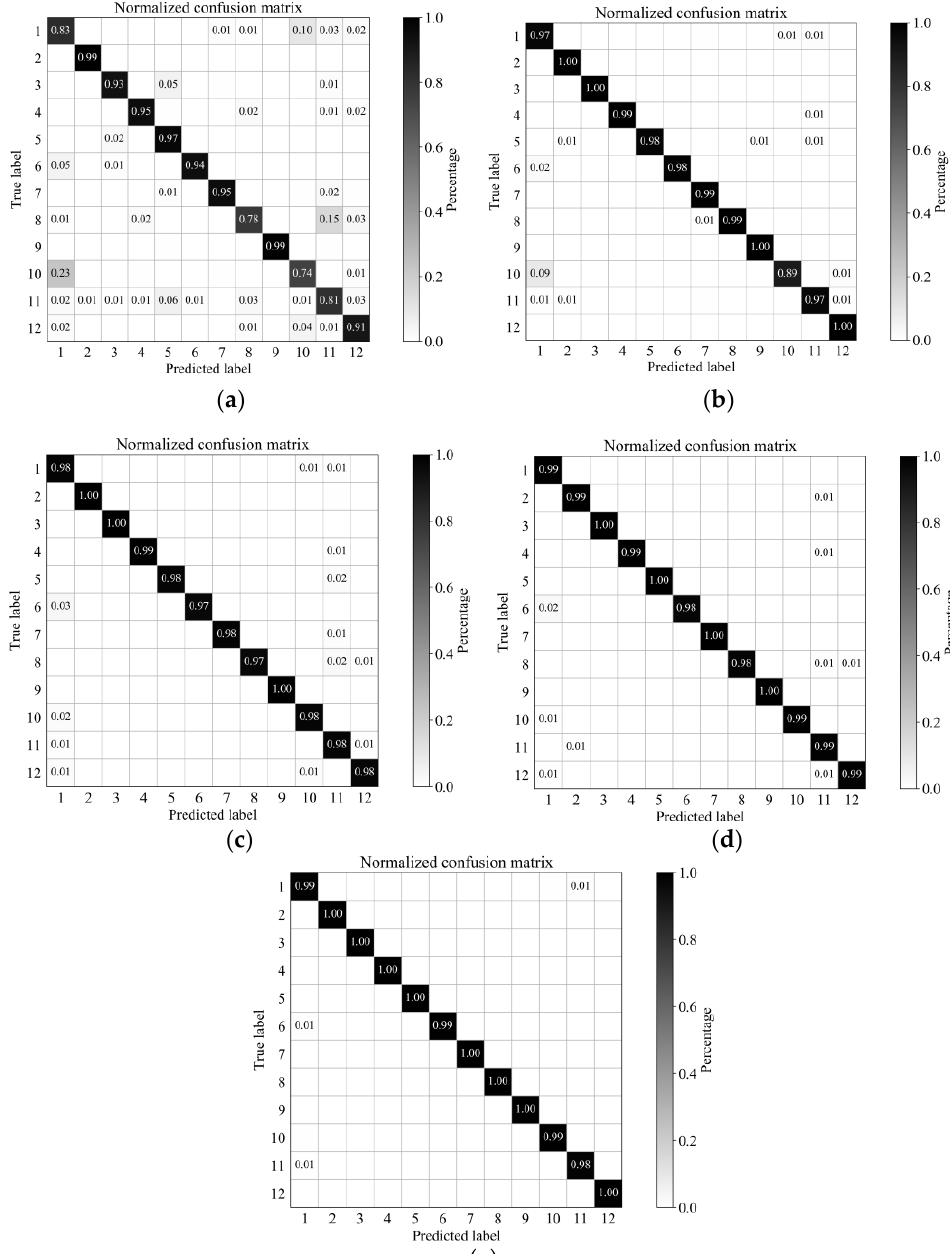
Figure 15. GF5AX dataset: Normalized confusion matrix of classification results using different